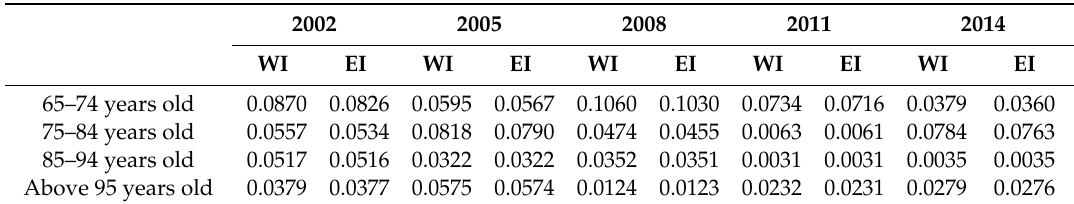
Table 5. Distribution of Wagstaff index (WI) and Erreygers index (EI) in different age groups from 2002 to 2014.